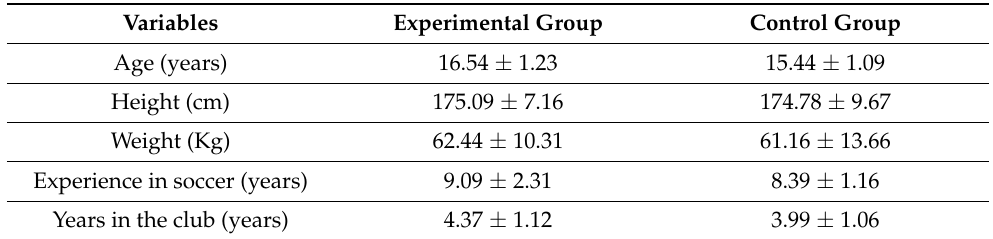
Table 1. Characteristics of the